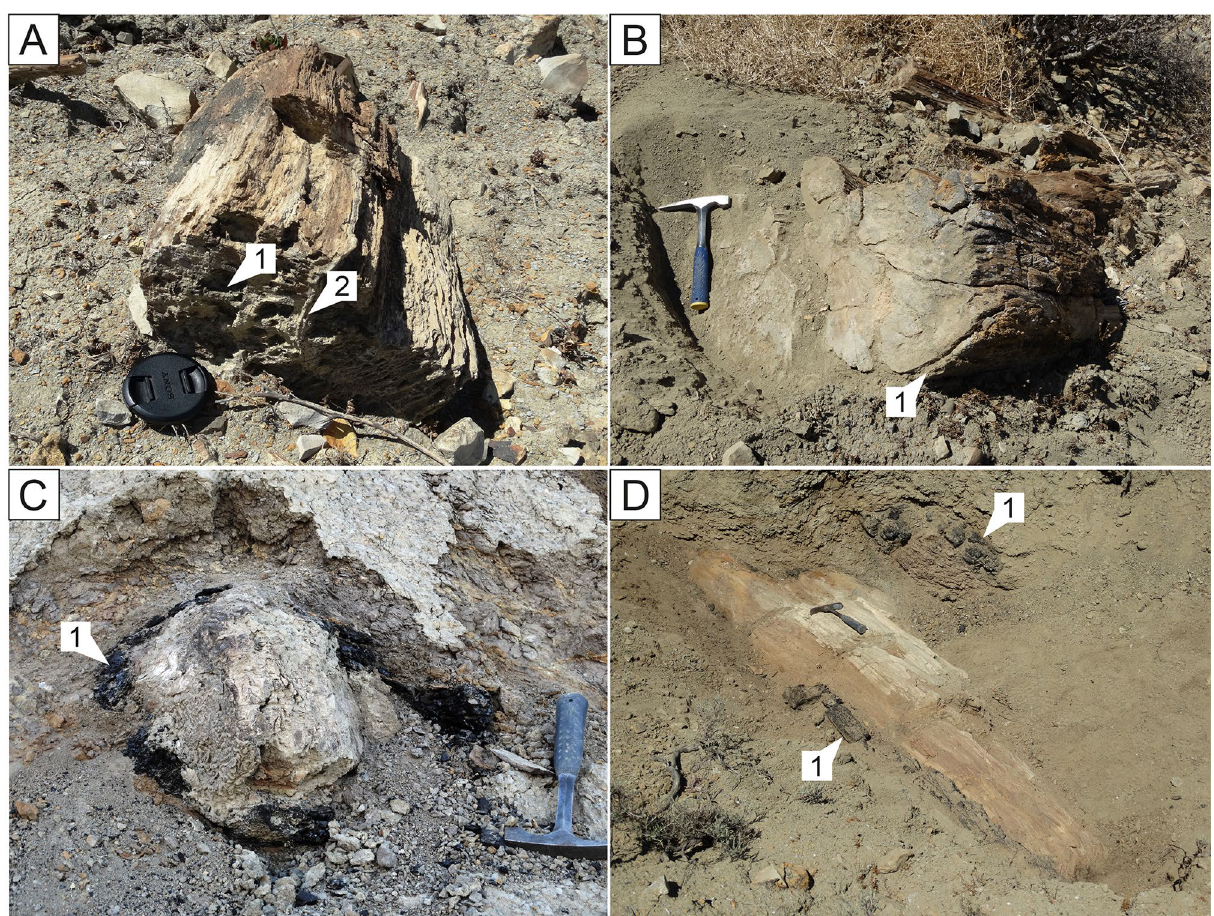
of trunks indicated by (1) (hammer is 30 cm